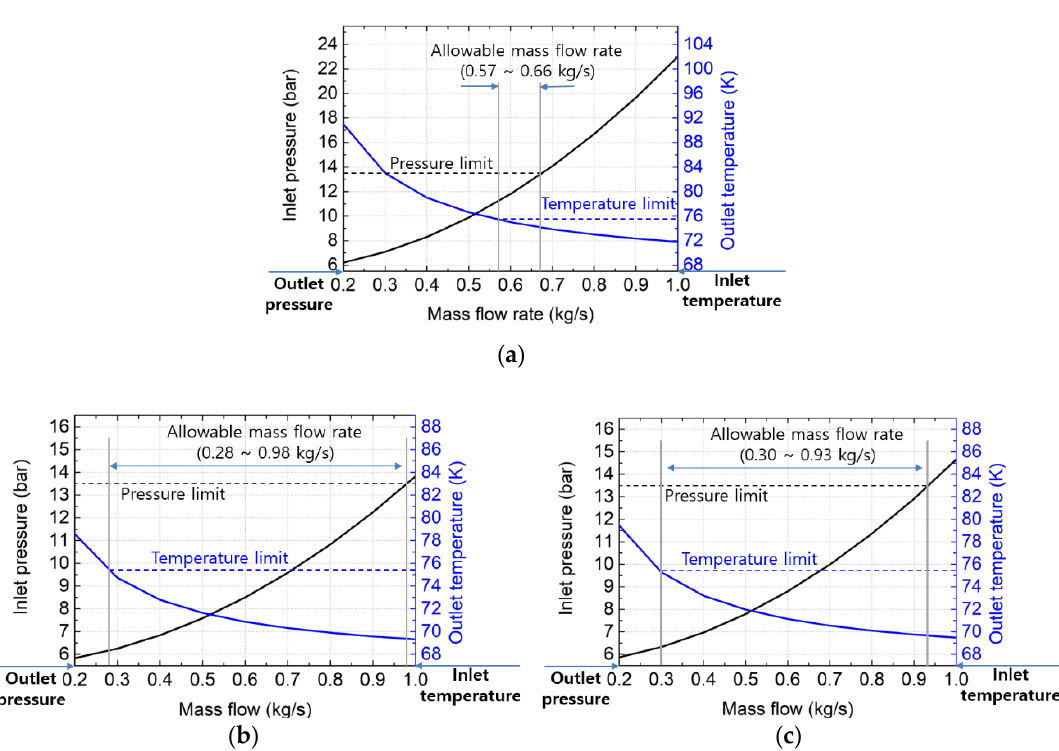
Figure 8. Allowable mas flow rates that meets the pressure limit and temperature limit for various cooling modes: ( a ) single cooling system; ( b ) dual cooling system, Munsan side; ( c ) dual cooling system, Seonyu side.